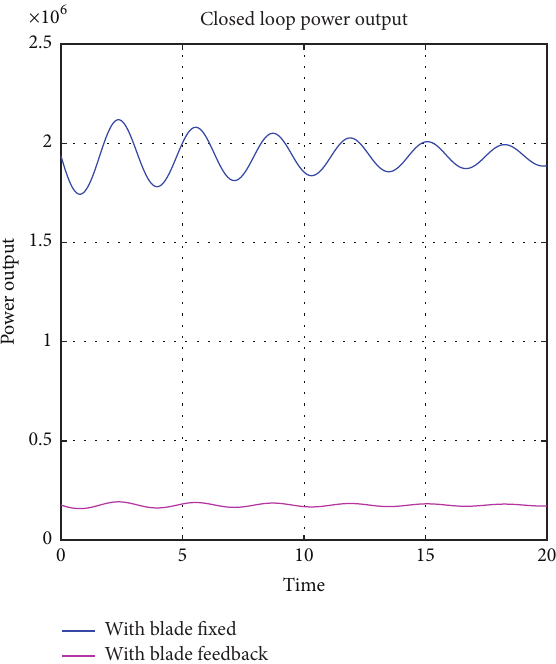
Figure 11: Responsecurves forthepower output with the prescribed limit set at 0Kw and the blade angle limited to 𝜃 𝑑 = 11 ∘ .